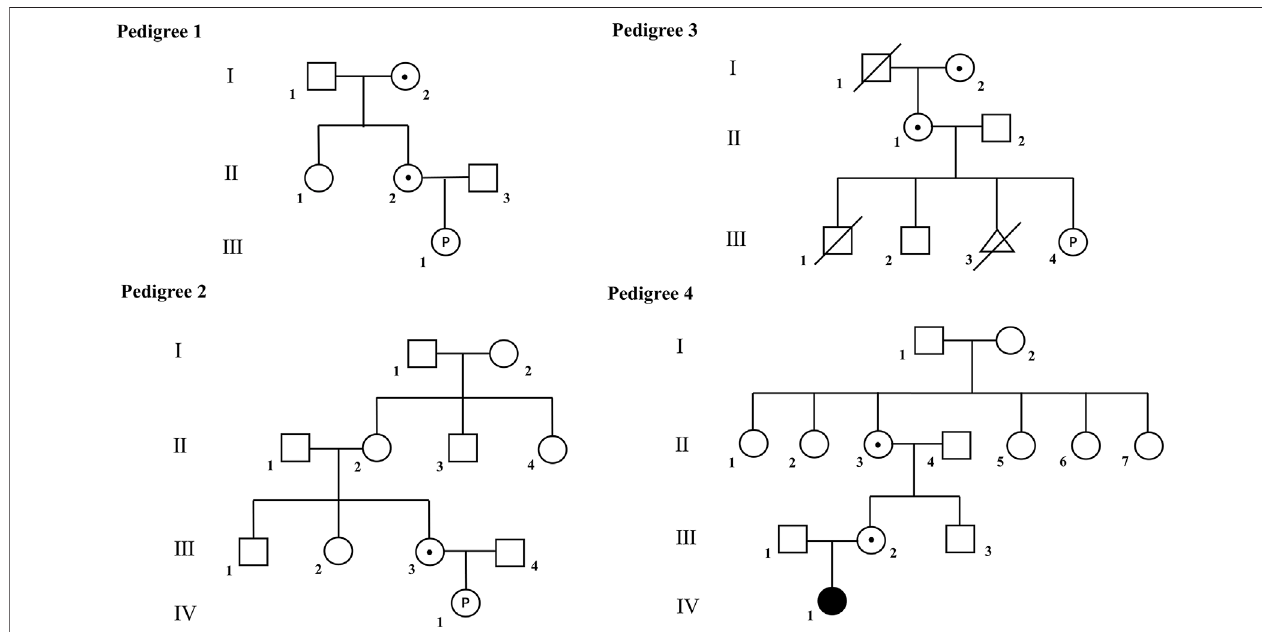
FIGURE1| Pedigreesofthefamiliesrecruitedinthisstudy.Filledsymbolindicatesaffectedindividuals;opensymbolsindicateunaffectedindividuals;opensymbols with dot indicate asymptomatic carriers. Open symbols with letter “ P ” indicate the unborn fetus.